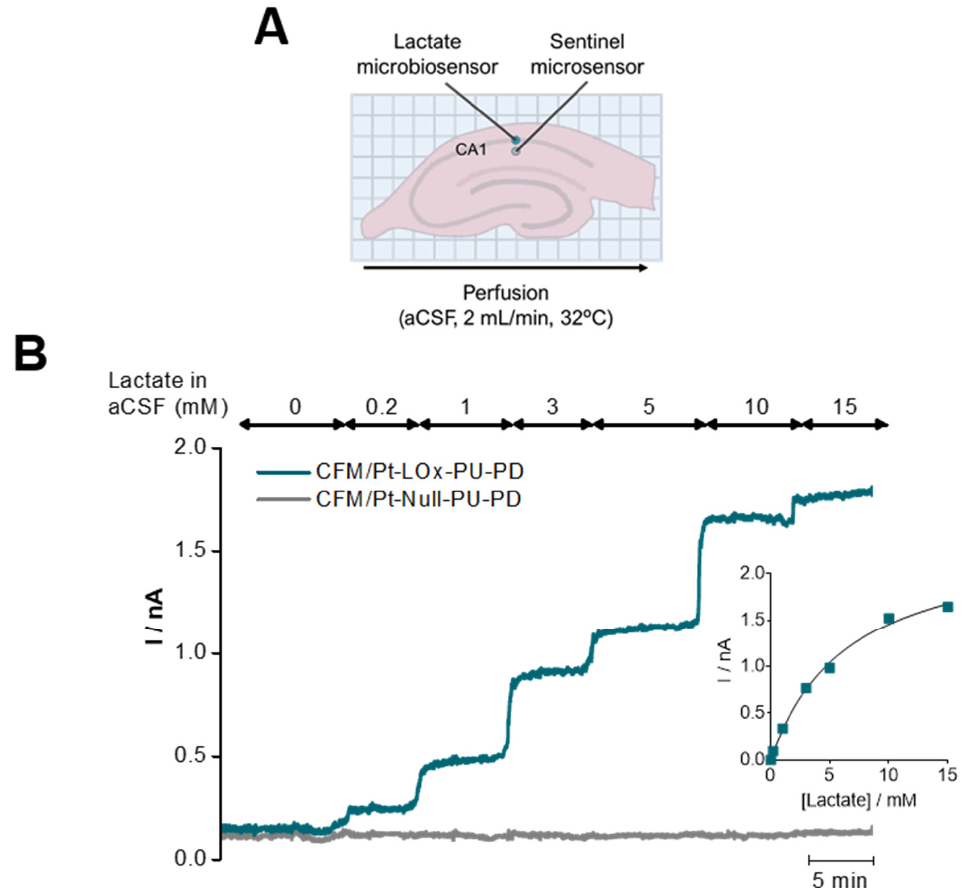
Figure 5. Validation of the suitability of the CFM/Pt-LOx-PU-PD for monitoring lactate in hip- pocampal slices. ( A ) Schematic representation of insertion sites for both the lactate (blue) and null microsensors (grey) in the hippocampal slice, CA1 subregion. ( B ) Recording of lactate in the extracellular space of hippocampal slices upon incremental increases of lactate in the perfusion media.